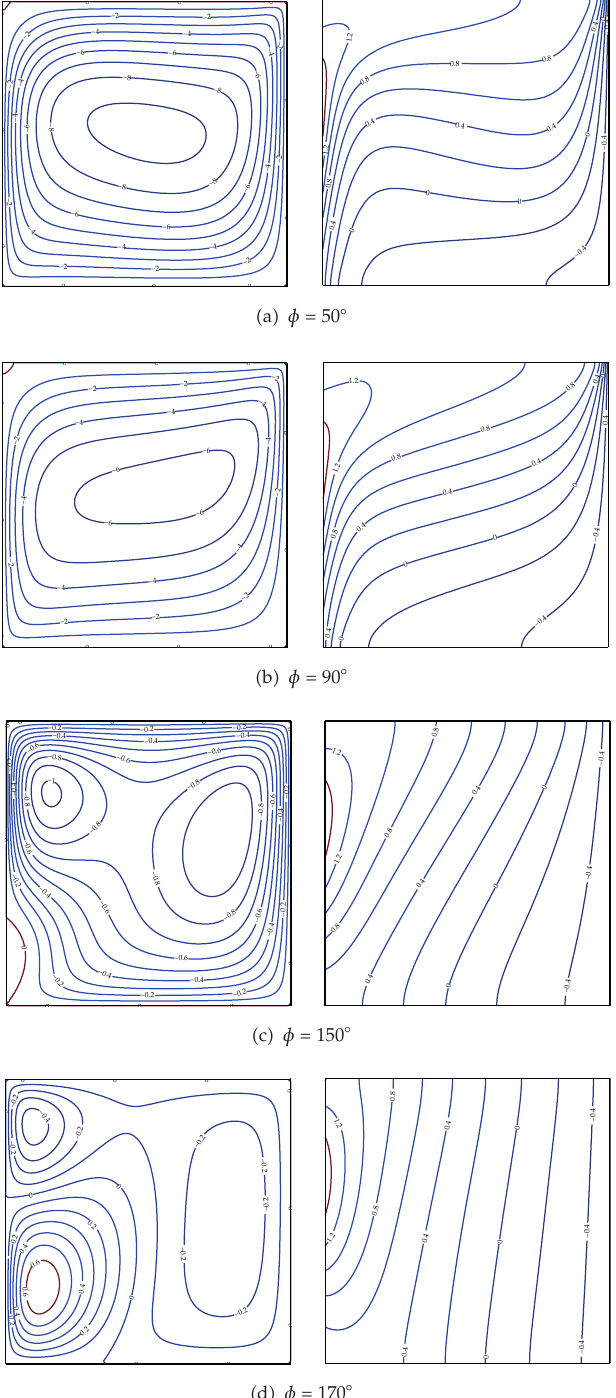
Figure 2: E ff ects of inclination angle φ on streamlines (cid:5) left (cid:6) and isotherms (cid:5) right (cid:6) for ε (cid:8) 0 . 5, κ (cid:8) 0 . 75, and Ra (cid:8)